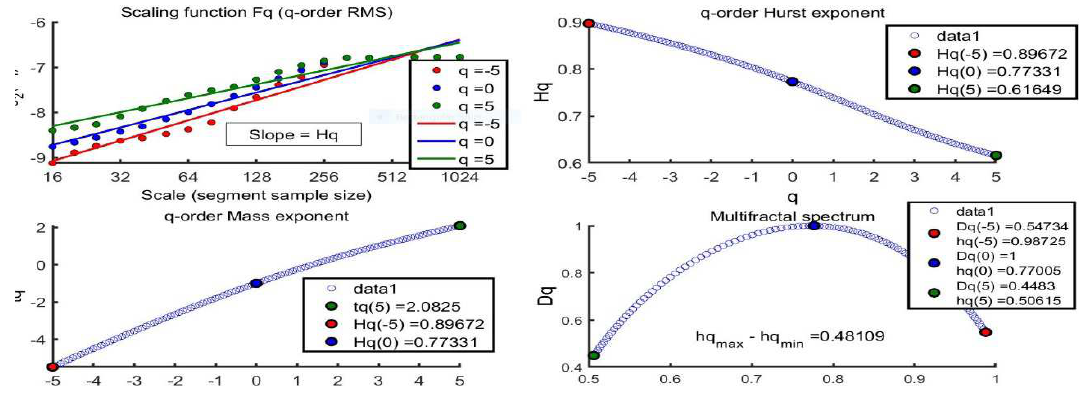
Figure A2. Hurst exponent value Hq (5) in 2012